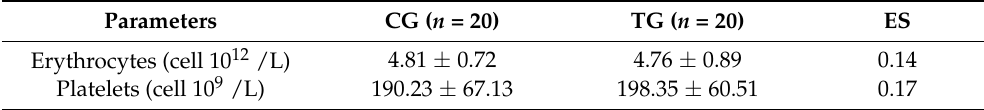
Table 3. Erythrocytes and platelets